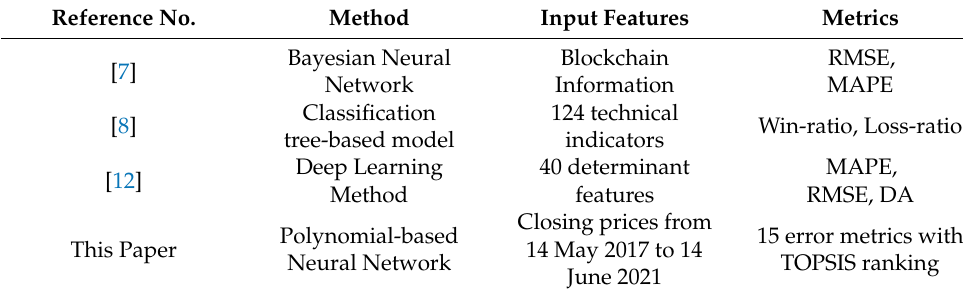
Table 13. Comparison of proposed work with other published work. Reference